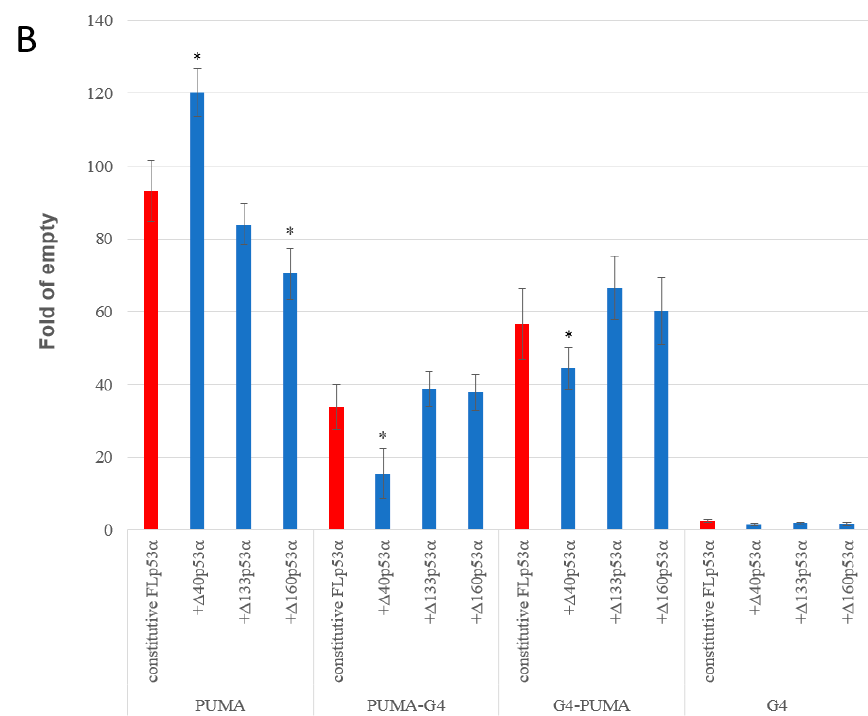
Figure 5. Influence of ∆ p53 α isoforms with inducible expression on transactivation activity of constitutively expressed FLp53 α . ( A ) in media with 0.2 % galactose; ( B ) in media with 2% galactose. Four isogenic yeast strains were used, with the p53 target site (PUMA), with the p53 target site after G4 forming sequence (G4-PUMA), with the p53 target site before G-quadruplex forming sequence (PUMA-G4), and the G4 forming sequence upstream of the luciferase gene. Asterisks indicate a significant induction of p53-dependent transactivation ( p < 0.05).